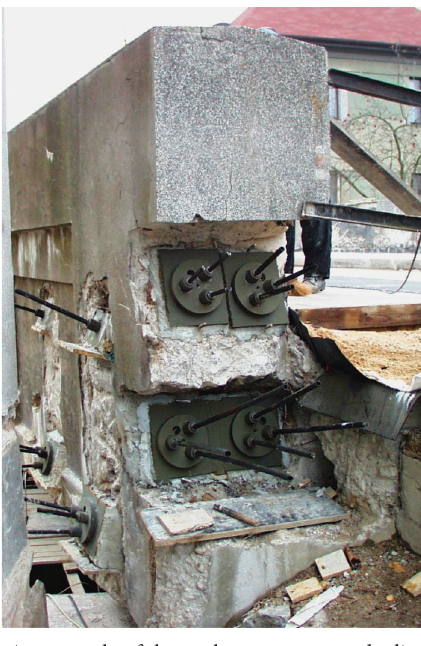
Figure 8: An example of the anchorage areas made directly in the existing concrete of the main girders of U-shaped bridge. The strengthening was implemented in 2002, so the old type of anchors was used